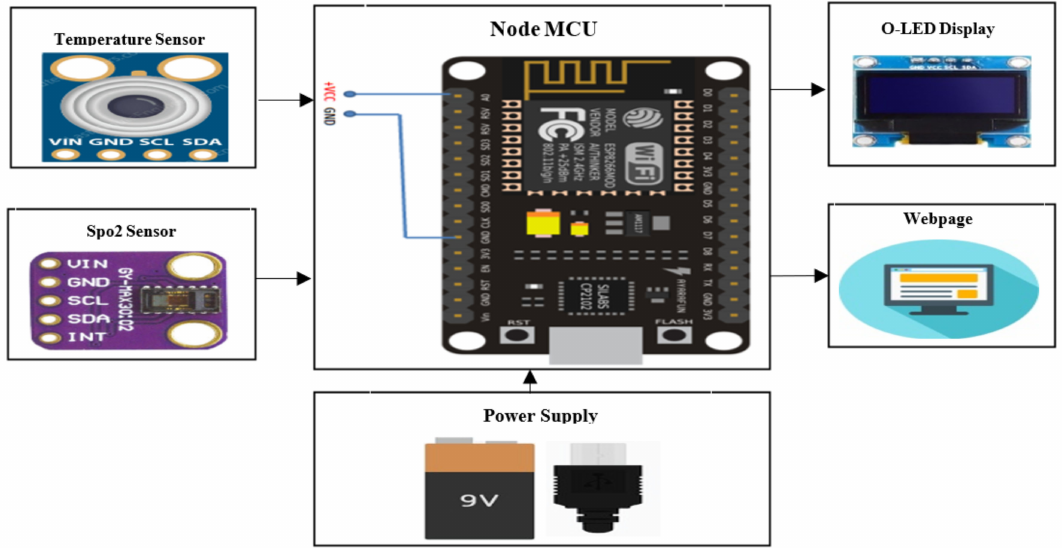
Figure 8. Schematic diagram of the sensing and measurements stage. The sensing and measurements stage consists of five components: Node-MCU con- troller, Sensing elements (SpO 2 and Temperature Sensor), power supply, O-LED display, and